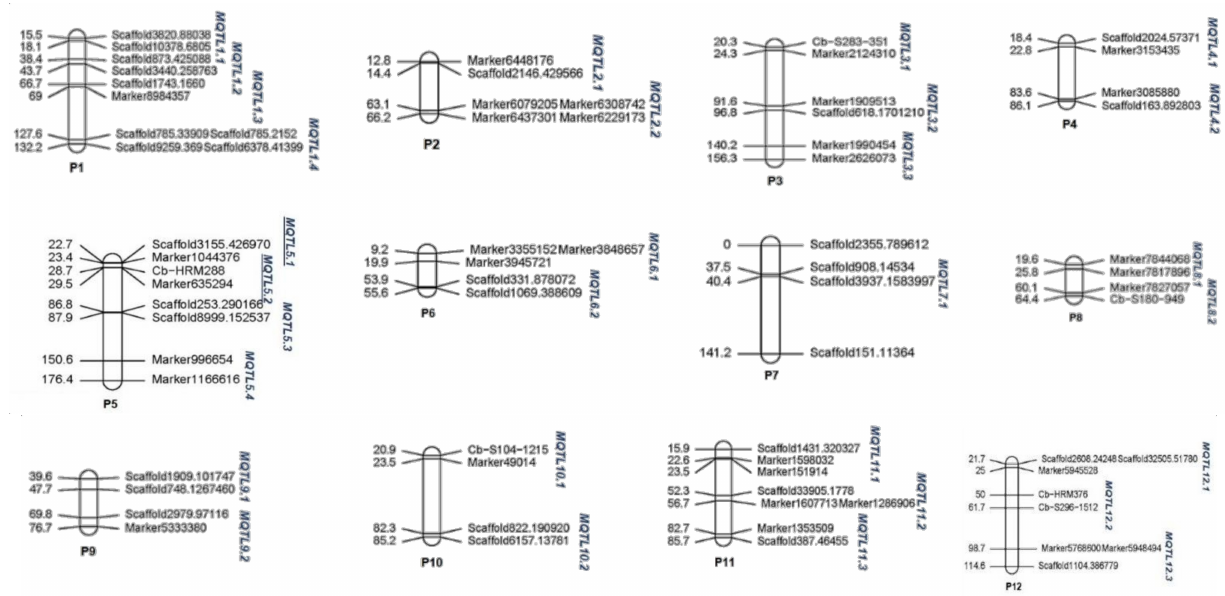
Figure 2. Meta-QTL and their flanking markers identified using 29 linkage mapping studies for diverse sets of traits for Capsicum spp. QTLome. Meta-QTL with underline are those with confidence intervals delimited to <1.0